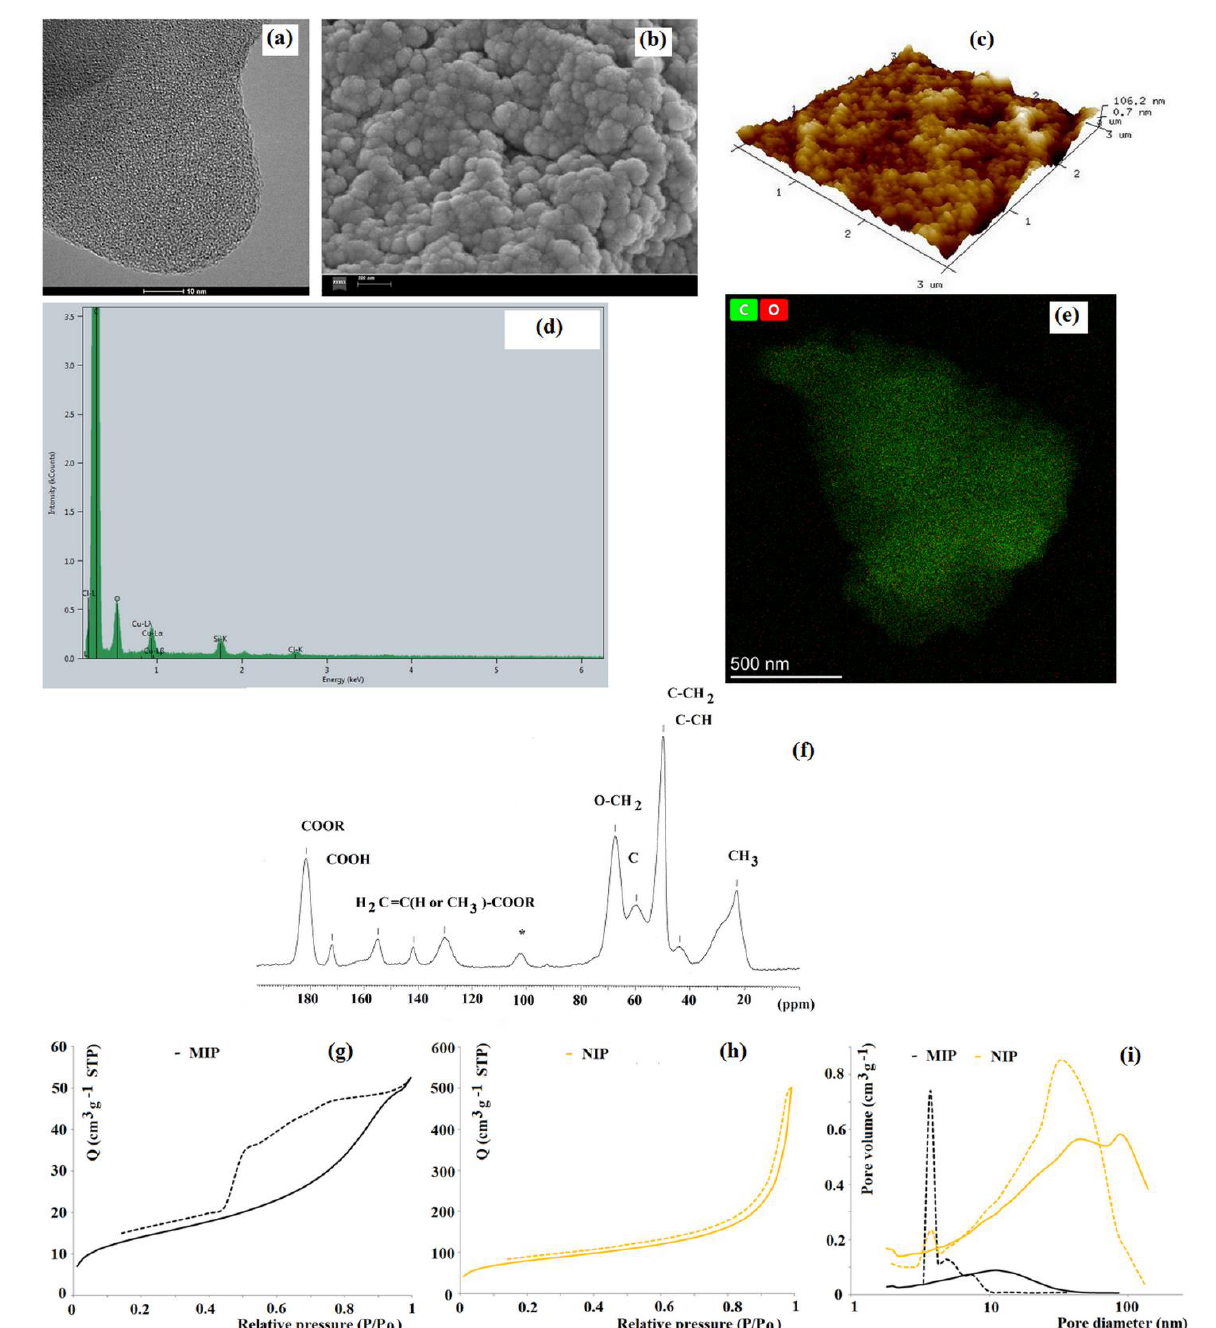
Figure 1. The transmission ( a ), scanning ( b ) electron, and atomic force ( c ) micrographs of imprinted sorbent together with elemental mapping from X-ray electron dispersive ( d , e ) and 13 C CP/MAS NMR spectroscopies ( f ) as well as nitrogen sorption data ( g – i ) [30].